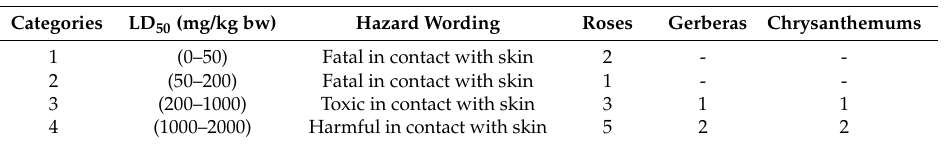
Table 7. Number of a.s. detected on cut flowers belonging to each category of acute toxicity hazard for the dermal route of exposure (CLP classification) [26–31].